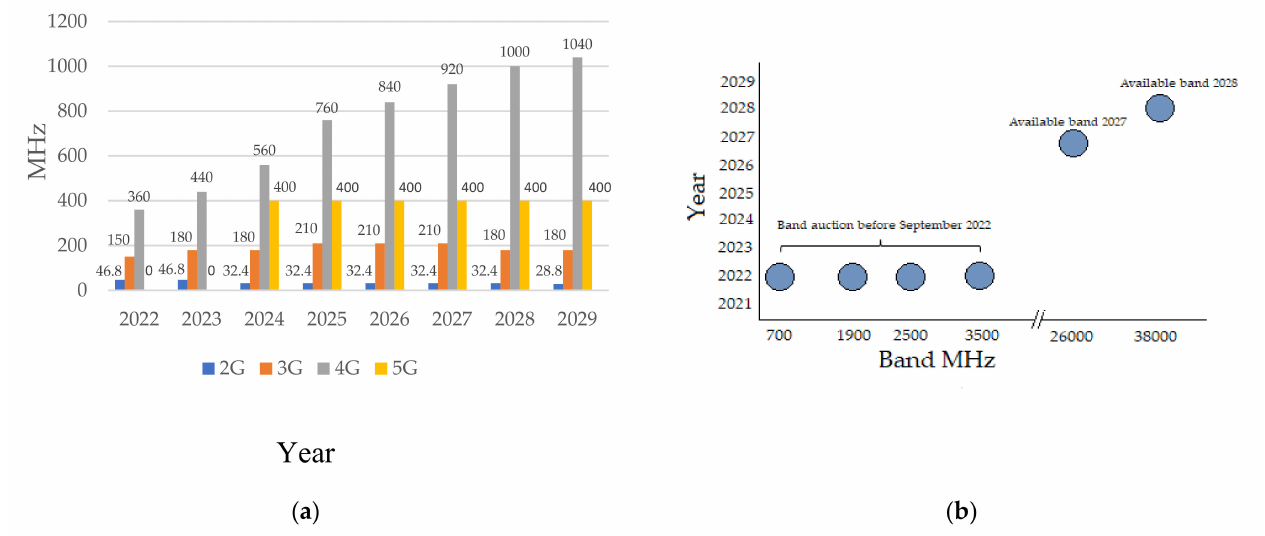
Figure 2. ( a ) Prospective spectrum demand for Colombia IMT, and ( b ) Band auctions projections. Source: ANE and